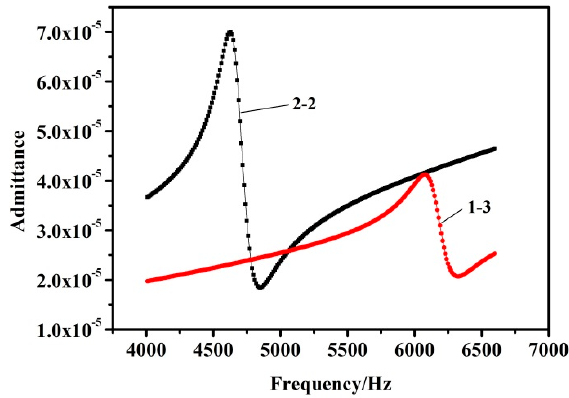
Figure 5. Admittance curve of the 2-2 and 1-3 piezoelectric composite bilaminated vibrators. Table 2. Results of the finite element simulation.